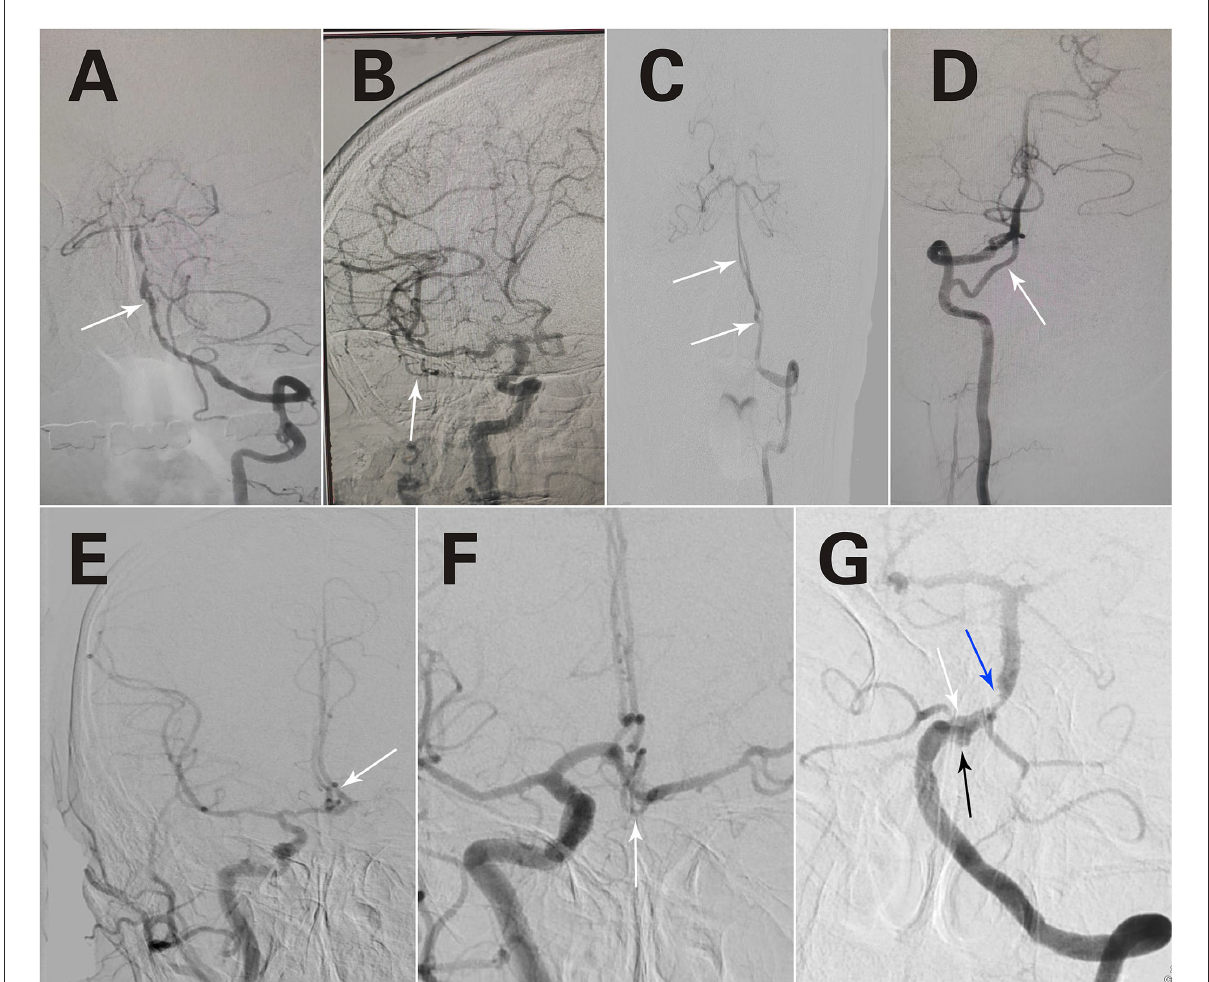
FIGURE1 Different forms of fenestrations. A slit-like configuration (A) . A convex lens-like shape (B) . Duplication of arteries (C) . Irregular morphology (D) . Triple fenestrations of the anterior communicating artery (E) . An irregular morphology of the fenestration in the anterior communicating artery (F) . Two fenestrations are located in the VA and BA, respectively (C) . A fenestration was observed in BA, an aneurysm was located at the fenestration site, and basilar artery stenosis was observed (G) . The white arrows refer to fenestration; The black arrow refers to aneurysm; The blue arrow refers to artery